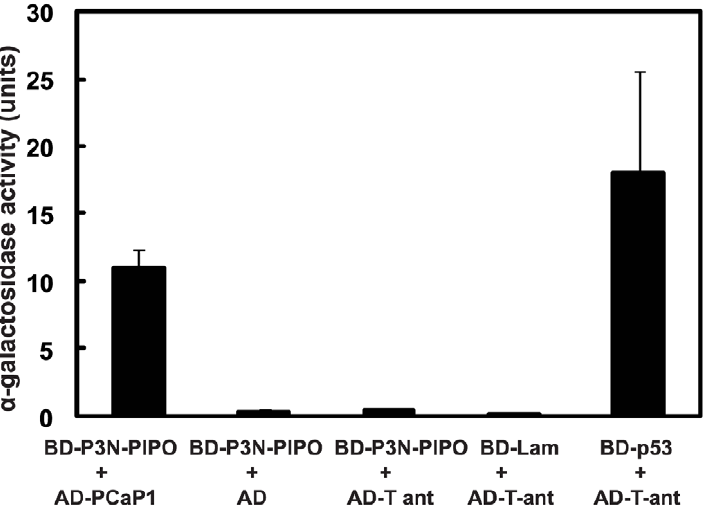
Figure 3. Interaction of P3N-PIPO with Arabidopsis PCaP1 in yeast cells. Yeast strain Y2HGold co-transformed with the BD-P3N-PIPO bait vector in combination with either the PCaP1 prey vector (AD-PCaP1), empty prey vector (AD), or T-antigen prey vector (AD-T antigen), and plated on non-selective medium (SD/ 2 Leu/ 2 Trp/ + X- a -Gal). Individual colonies of each combination were picked to quantify interaction by a -galactosidase activity in liquid medium. Data are average of eight replicates from three independent experiments. Error bars represent standard deviations. Negative control: BD-lam and AD-T-ant, positive control: BD-murine p53 and AD-T-ant, lam (human lamin C), SV-40 large T-antigen (T-ant), binding domain (BD), activation domain